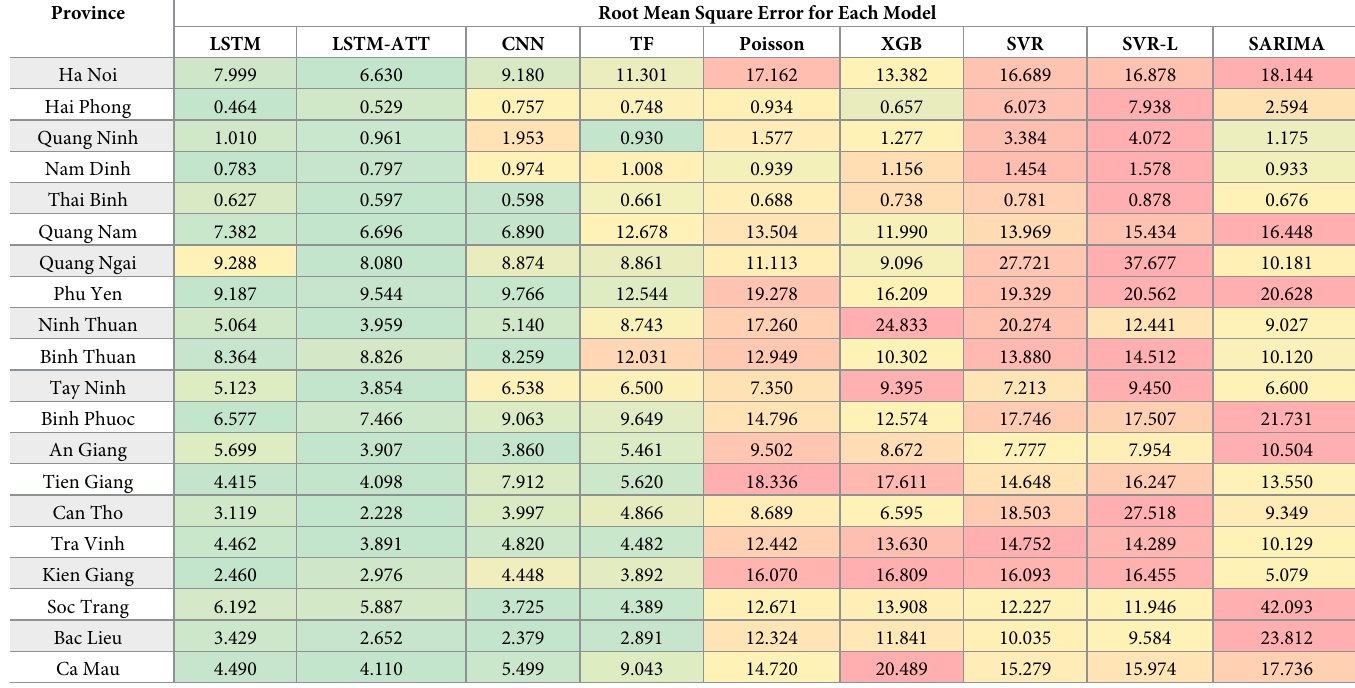
Values are colour-coded for each province separately from the lowest value (darker green) to the median value (yellow) to the highest value (darker red). LSTM = long short-term memory. LSTM-ATT = attention mechanism-enhanced LSTM. TF = Transformer. CNN = convolutional neural network. Poisson = Poisson regression. XGB = Extreme Gradient Boosting. SVR = Support Vector Regressor with Radial Basis Kernel. SVR-L = Support Vector Regressor with Linear Kernel. SARIMA = Seasonal Autoregressive Integrated Moving